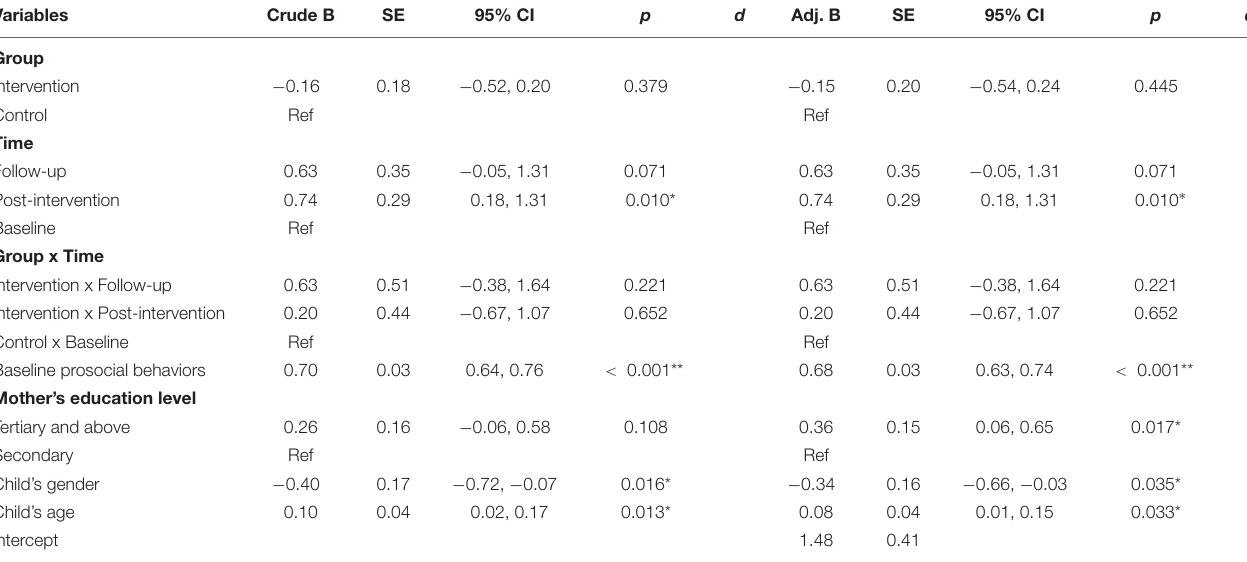
TABLE 2 | Prosocial behavior scores (SDQ-PRO) at baseline, post-intervention, and follow-up between groups.